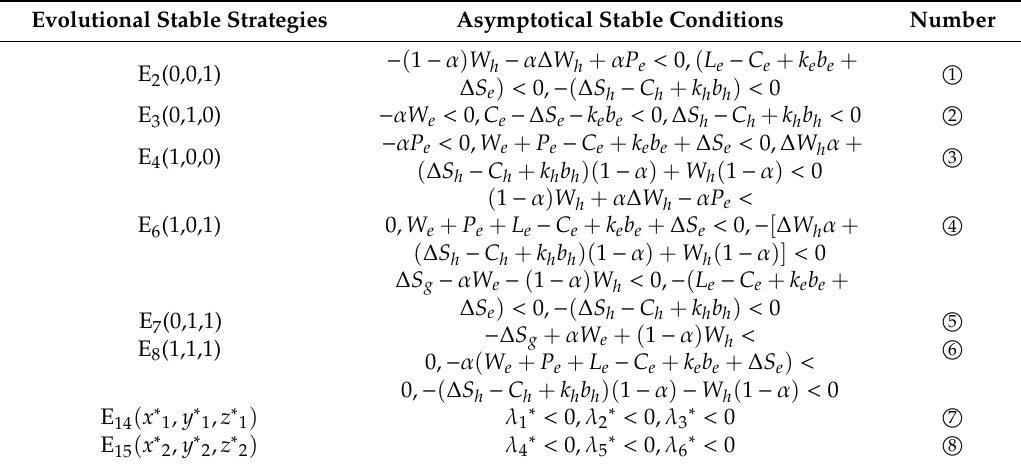
Table 3. The conditions of evolutionary stable